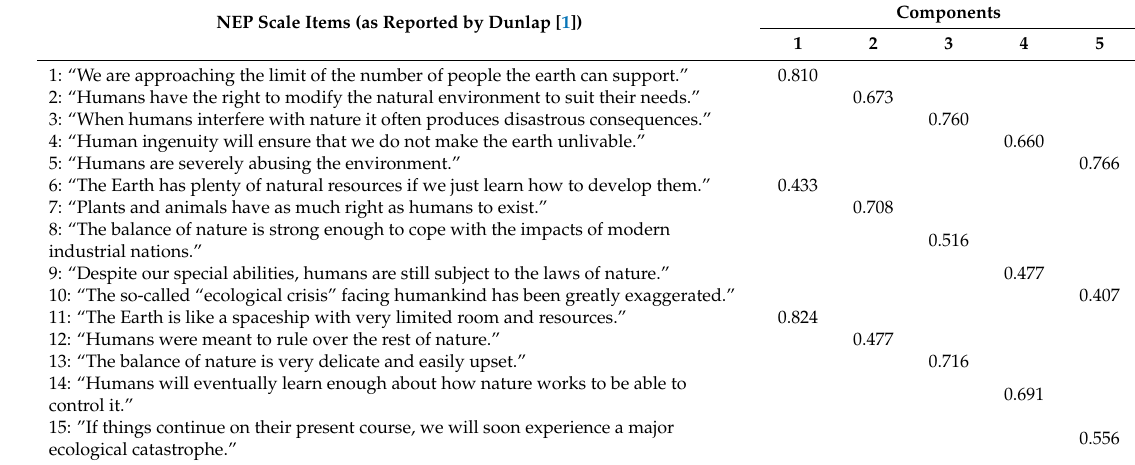
Table 3. Principal component analysis for the 15 items of the New Environmental Paradigm Scale (NEP).